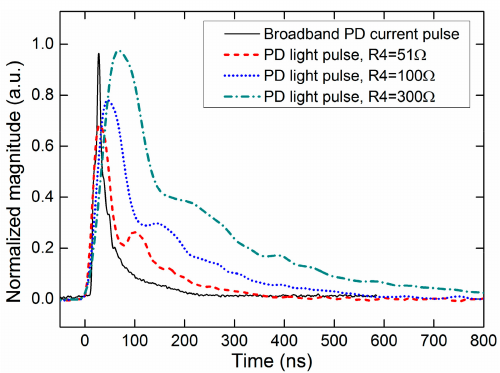
Figure 3. SiPM PD light pulse waveforms coupled with different external integral impedances in the primary stage. The PDs are excited by a positive polarity point in